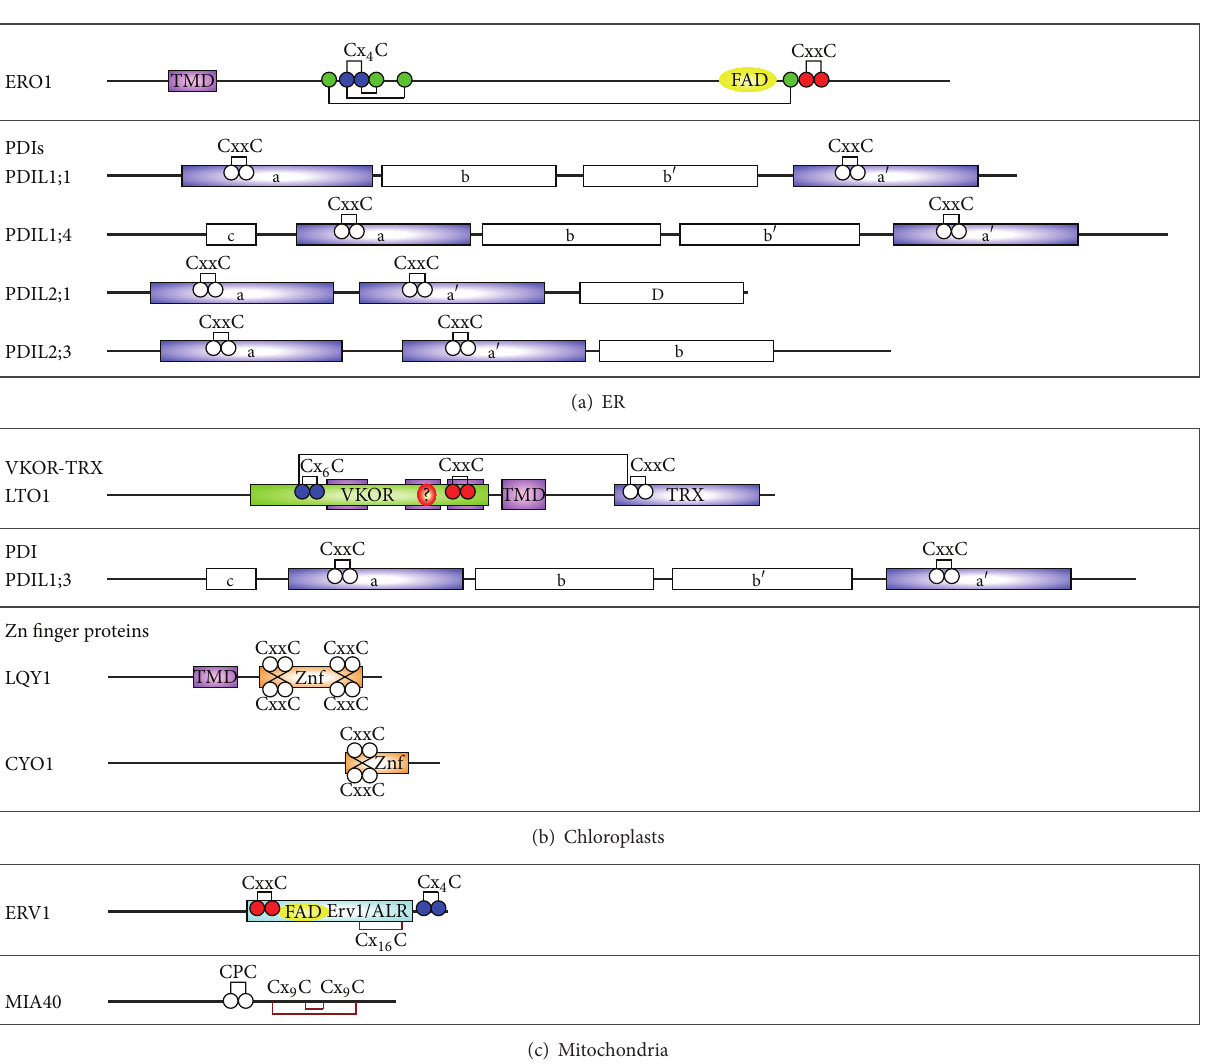
Figure 4: Main characterized components of the disulfide bond formation pathway in the ER, chloroplasts, and mitochondria of plant cells. (a) Schematic illustration of ERO1 and PDIs in the plant ER. (b) Schematic illustration of a VKOR homolog (LTO1) and thiol-disulfide oxidoreductases (PDIL1;3, LQY1, and CYO1) in chloroplasts. (c) Schematic illustration of ERV1 and MIA40 in mitochondria. In disulfide- generating enzymes (ERO1, LTO1, and ERV1), the predicted active-site Cys pairs, shuttle Cys pairs, and regulatory Cys pairs are indicated with red, blue, and green circles, respectively. The FAD cofactor is shown in yellow. No cofactor of LTO1 has been identified yet (question mark circled in orange). In disulfide carrier proteins and TRX domain of LTO1, the predicted redox-active Cys pairs (CxxC in TRX domains and Zn finger domains, CPC in MIA40) are indicated with white circles. The predicted structural Cys pairs in MIA40 (Cx 9 C) and ERV1 (Cx 16 C) are indicated with brown lines. Redox-active TRX (a and a 󸀠 domains; blue boxes), redox-inactive TRX (b and b 󸀠 ; white boxes), 𝛼 -helical D (white box), VKOR (green box), DnaJ Zn finger (Znf; orange boxes), and Erv1/ALR (cyan box) domains are predicted by NCBI